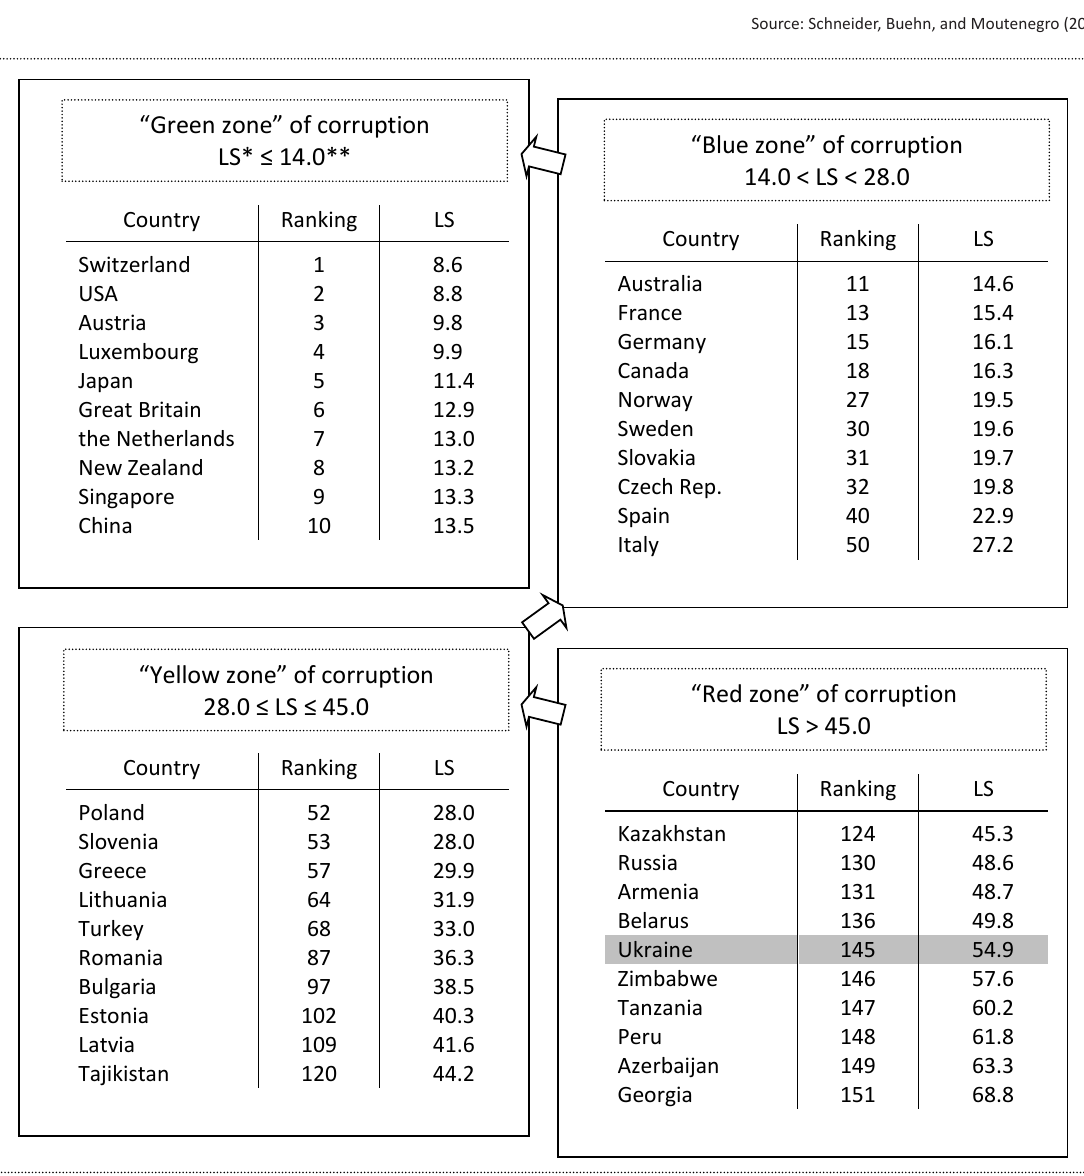
Figure 1. Four ‘colored’ zones of corruption in some countries in the world according to the ‘level of shadowing’ as a percentage of GDP (based on Schneider’s data,